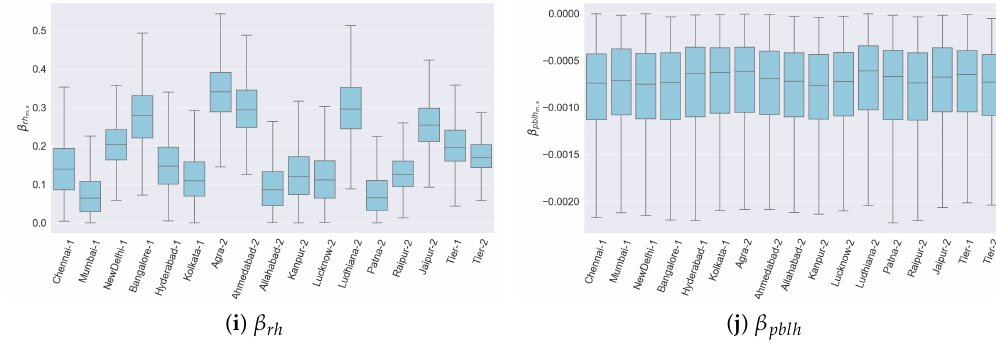
Figure 6. Boxplot of city-Tier and Tier level model parameters ( a ) EC O , ( b ) EC R , ( c ) EC C , ( d ) EC I , ( e ) EC agro , ( f ) EC BK , ( g ) EC V , ( h ) β wnd , ( i ) β rh , ( j ) β pblh inferred from hierarchical bayesian